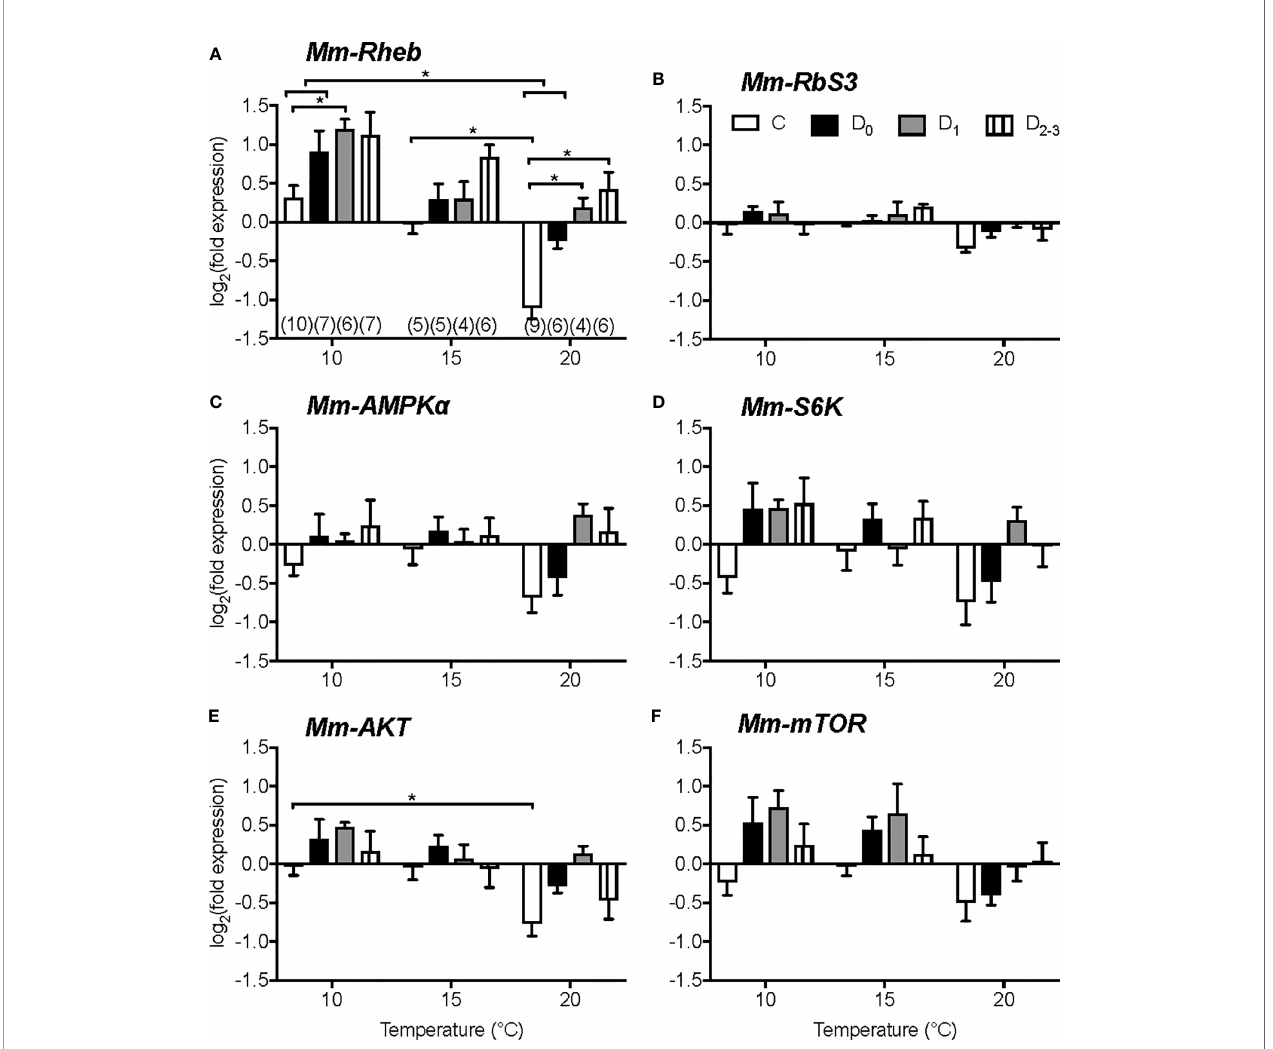
FIGURE 5 | Effects of temperature and molt stage on gene expression in Y-organs of juvenile Dungeness crab, Metacarcinus magister . mRNA levels of Mm - Rheb (A) , Mm - ribosome subunit 3 ( RbS3 ) (B) , Mm - AMPKa (C) , Mm - S6K (D) , Mm - AKT (E) , and Mm - mTOR (F) after 14 days at 10°C, 15°C or 20°C of juveniles in intermolt (C, white), early premolt (D 0 , black), mid-premolt (D 1 , grey), or late premolt (D 2-3 , lines). Data are normalized to the mean absolute mRNA copy numbers in stage C at 15°C. Asterisks denote signi fi cant differences at P < 0.05. Sample size ( n ) given in brackets below columns in A also apply to the other genes. Data are presented as mean ± 1 S.E.M. Mm-Rheb expression is affected by temperature and molt stage. Mm-Rheb mRNA level increases during premolt stages and decrease with increasing temperature. From